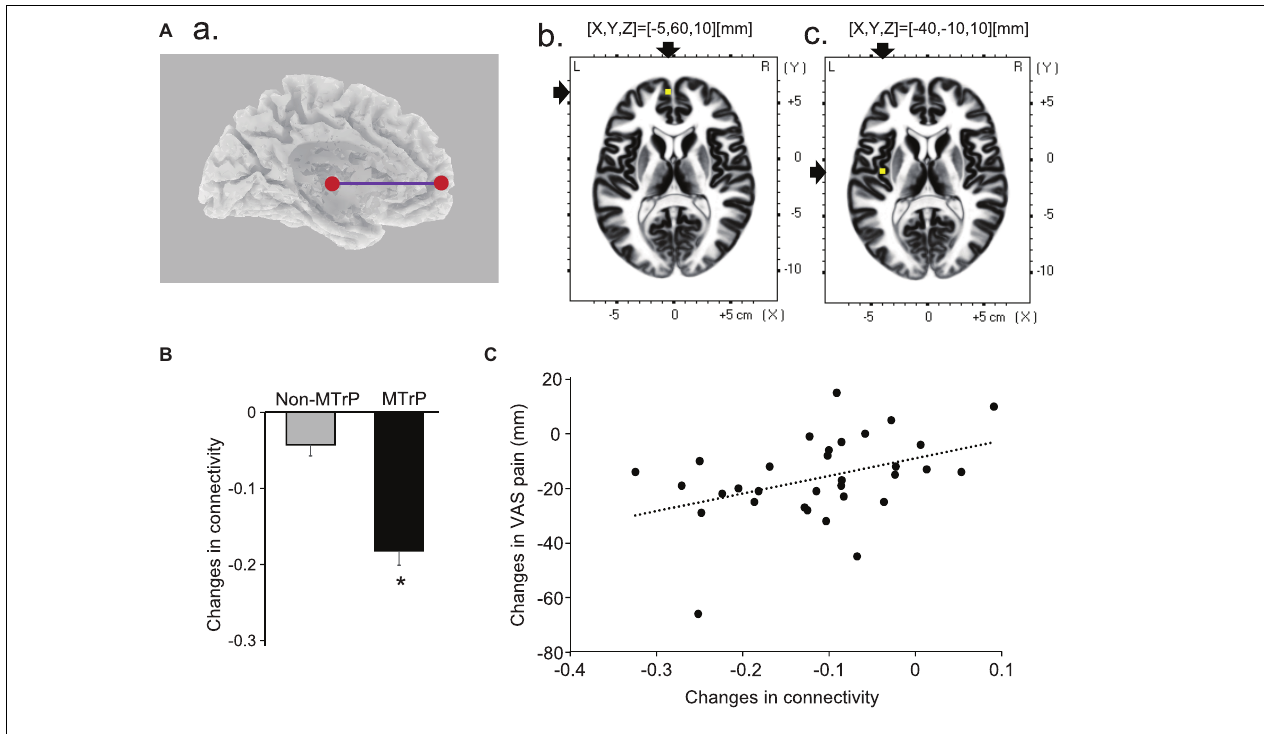
FIGURE 8 | Changes in functional connectivity between the MTrP and non-MTrP groups during compression. (A) A purple line indicates a functional connectivity between the left mpPFC and left insula cortex (INS13) with significant reduction during compression in the MTrP group compared with the non-MTrP group. (a) Right two panels show the locations of the left mpPFC (b) and left insula cortex (c) in the MNI coordinates. (B) Comparison of changes in functional connectivity between the left mpPFC and insula cortex during compression between the non-MTrP and MTrP groups. ∗ P < 0.05. (C) Relationships between functional connectivity changes shown in panel B and VAS pain changes during